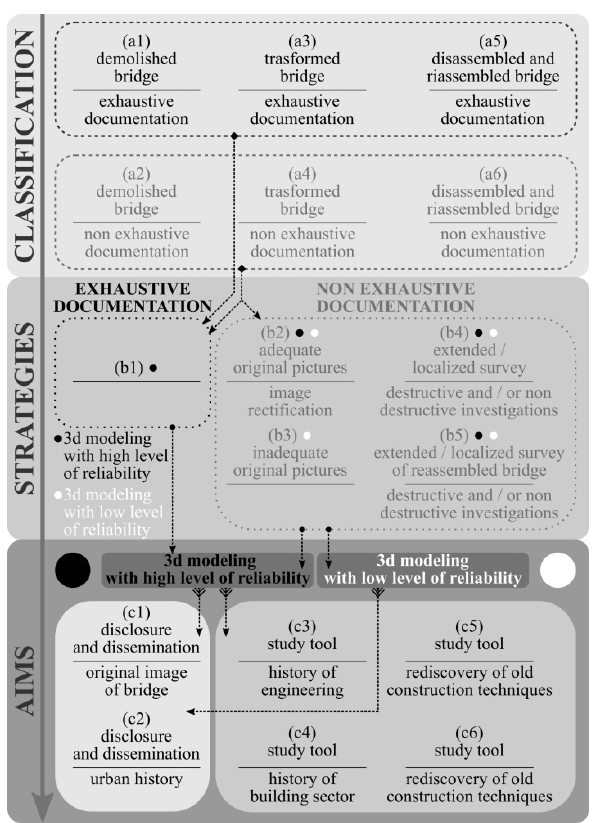
Figure 9. Diagram of the